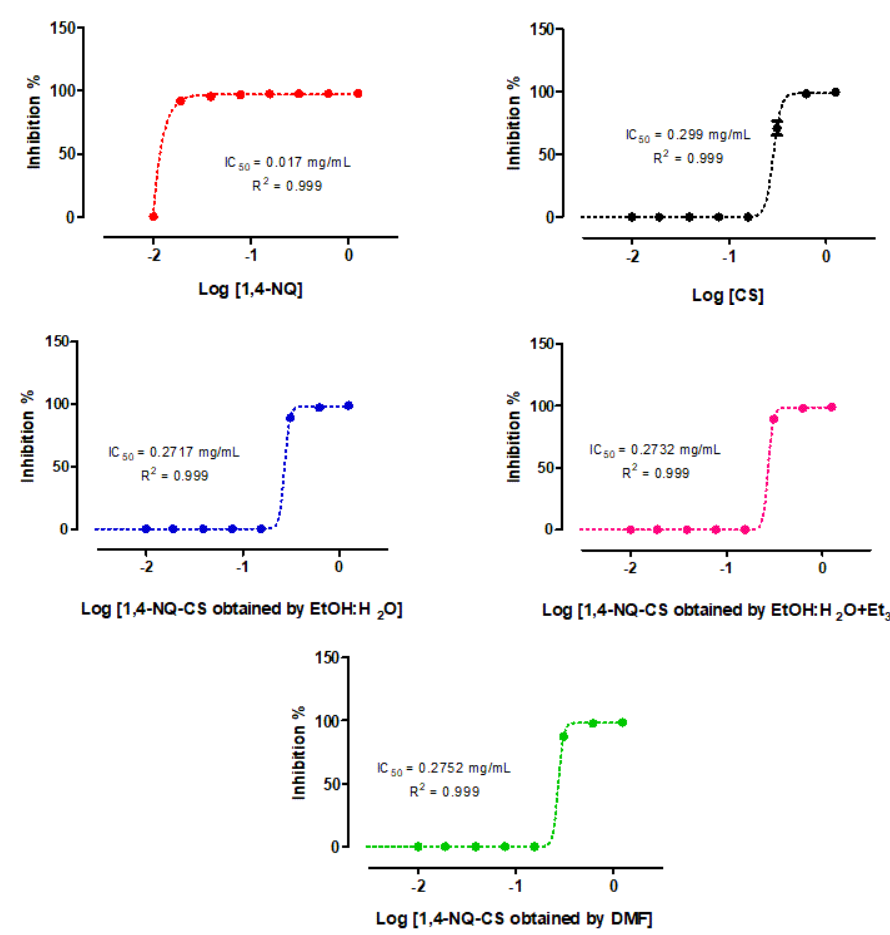
Figure 14. IC 50 estimation from the proliferation curves of human mammary adenocarcinoma cells (MDA-MB-231) exposed for 24 h to increasing 1,4-naphthoquinone-grafted chitosan doses (1,4-NQ-